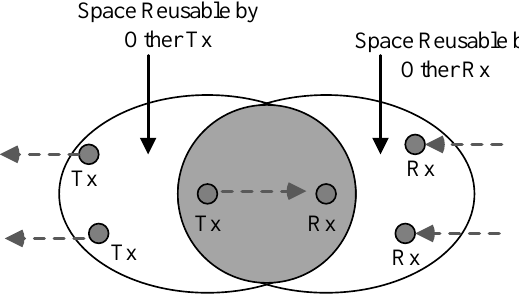
Figure 10. Half duplex transmission spatial reuse.